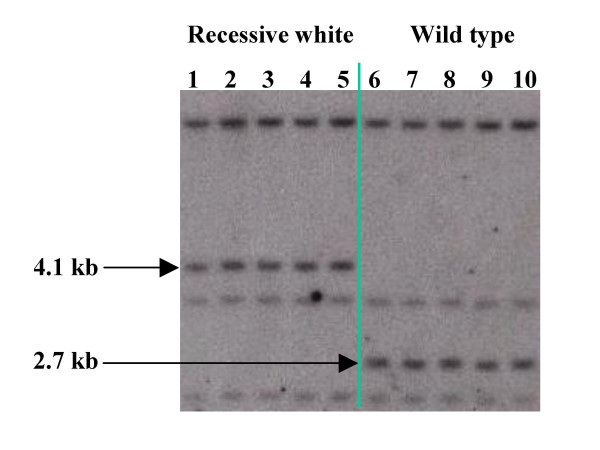
RFLP banding pattern revealed by hybridization with a total chicken tyrosinase cDNA probe after HindIII digestion of genomic DNA from recessive white mutant and wild type chickens. Lane 1, 2, 3, 4, 5: recessive white chicken genomic DNA. Lane 6, 7, 8, 9, and 10: wild type (colored chicken) genomic DNA. The 4.1 kb band was only found in homozygous recessive white chickens while the 2.7 kb band was only found in the wild type chickens.